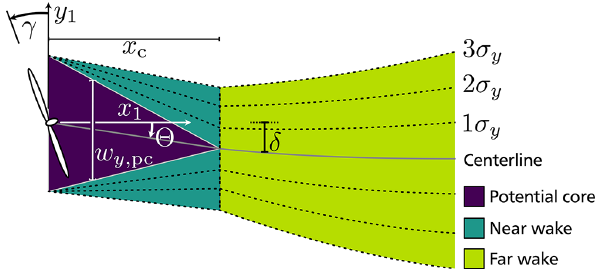
Figure 1. Sketched shape of the wake with the different sections, the deflection and areas of equal relative reduction by the Gaussian